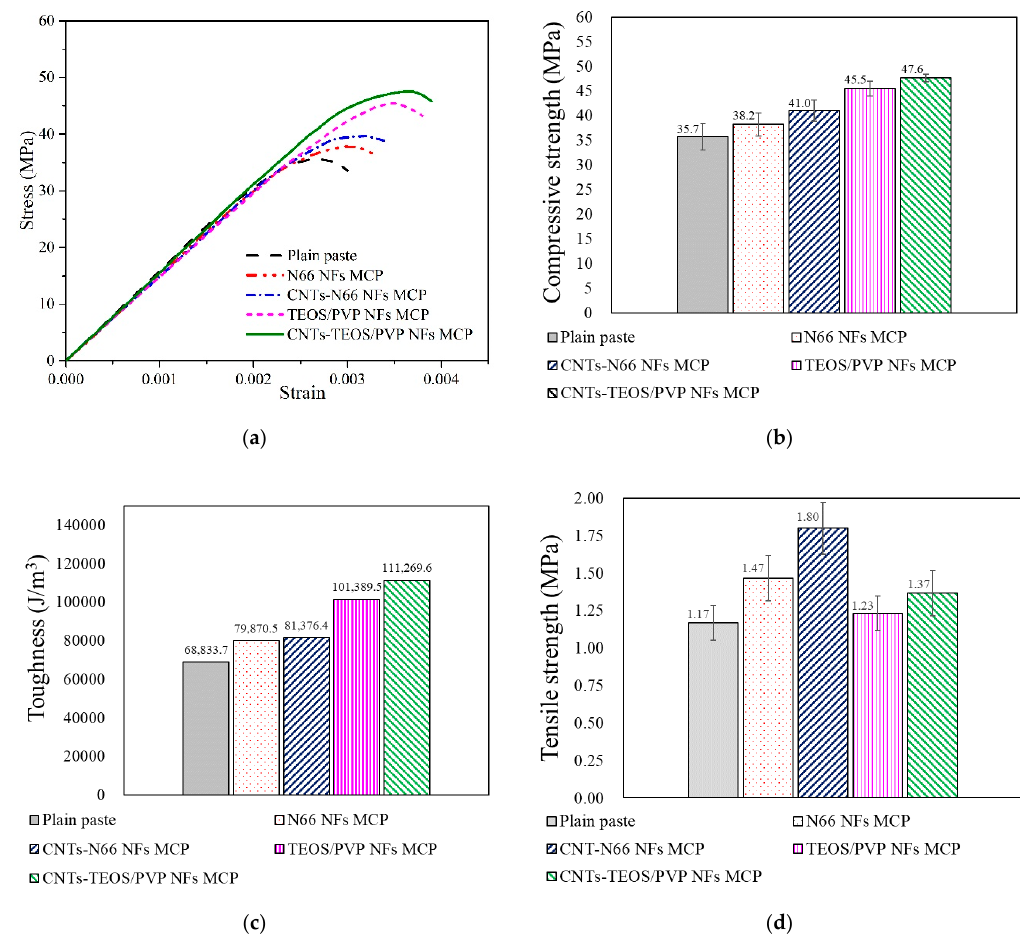
Figure 3. The 28-day mechanical properties: ( a ) the 28-day stress–strain curves; ( b ) the 28-day compressive strength results; ( c ) the 28-day toughness results.; ( d ) the 28-day tensile strength results. Table 4. Ductile deformation